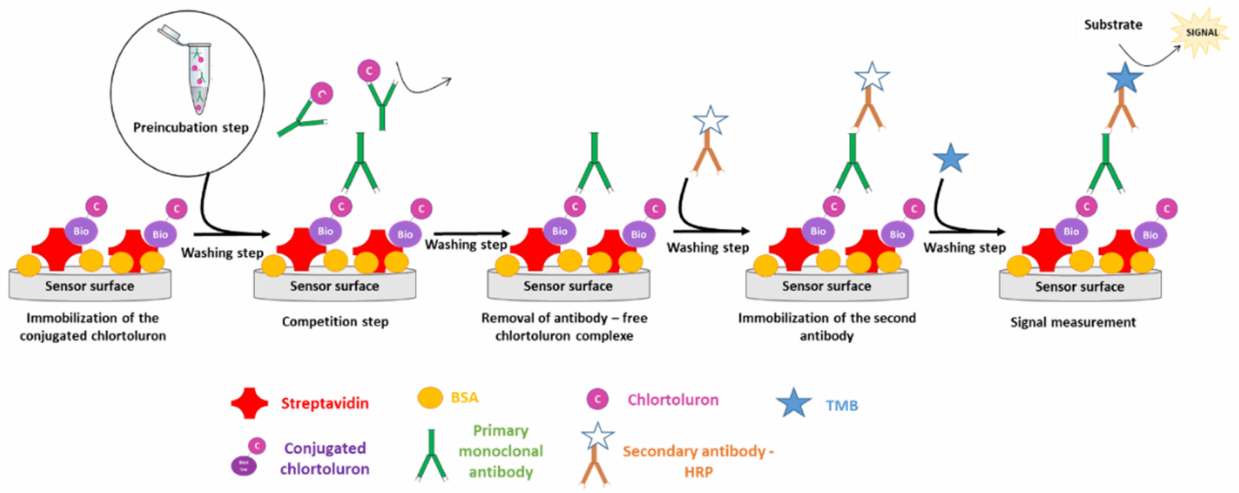
Figure 2. Description of indirect detection based on the competition between immobilized conjugated chlortoluron and free chlortoluron for their binding to primary